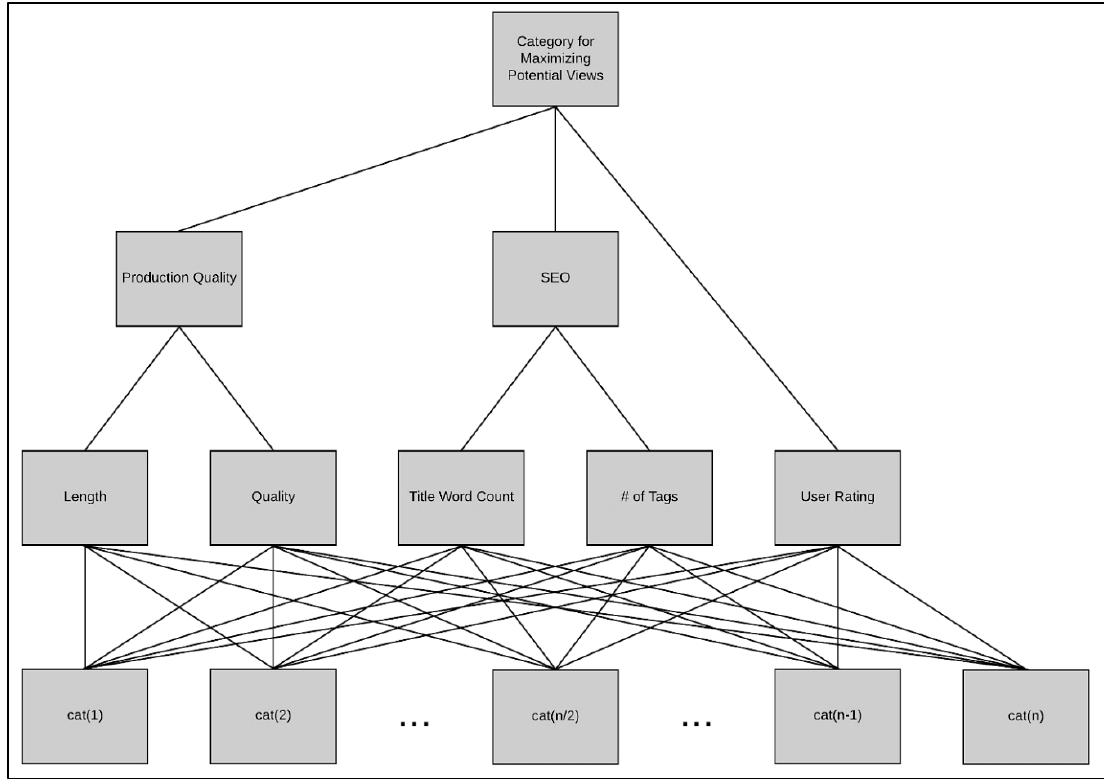
Figure 1. Generalized AHP